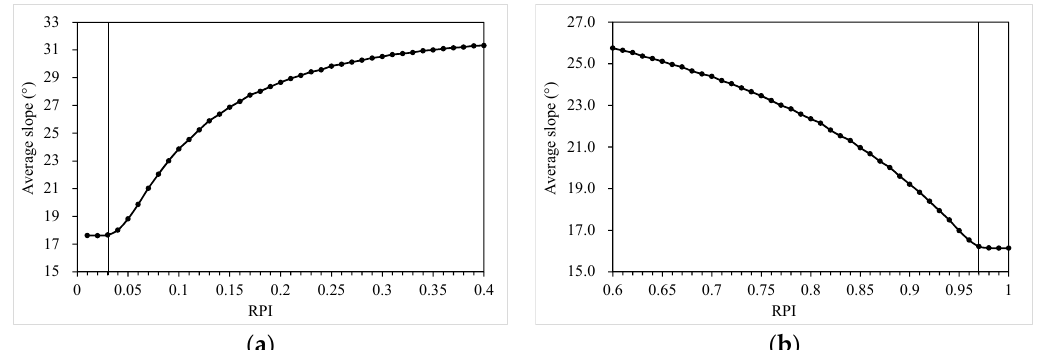
Figure 4. Distribution of RPI.